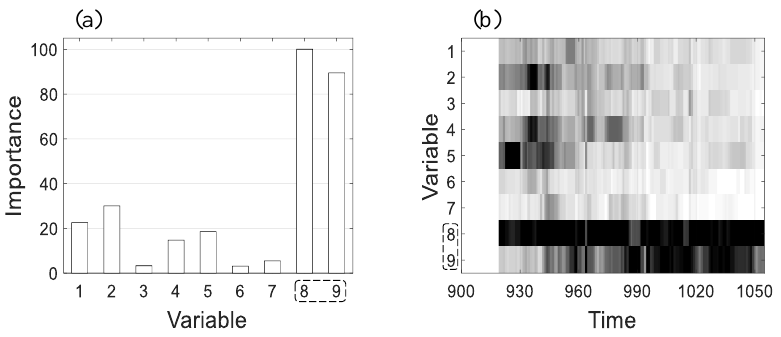
Figure 12. (Failure data due to waterwall tube leakage) Results of faulty variable isolation using the proposed method: ( a ) Method 1; ( b ) Method 2.